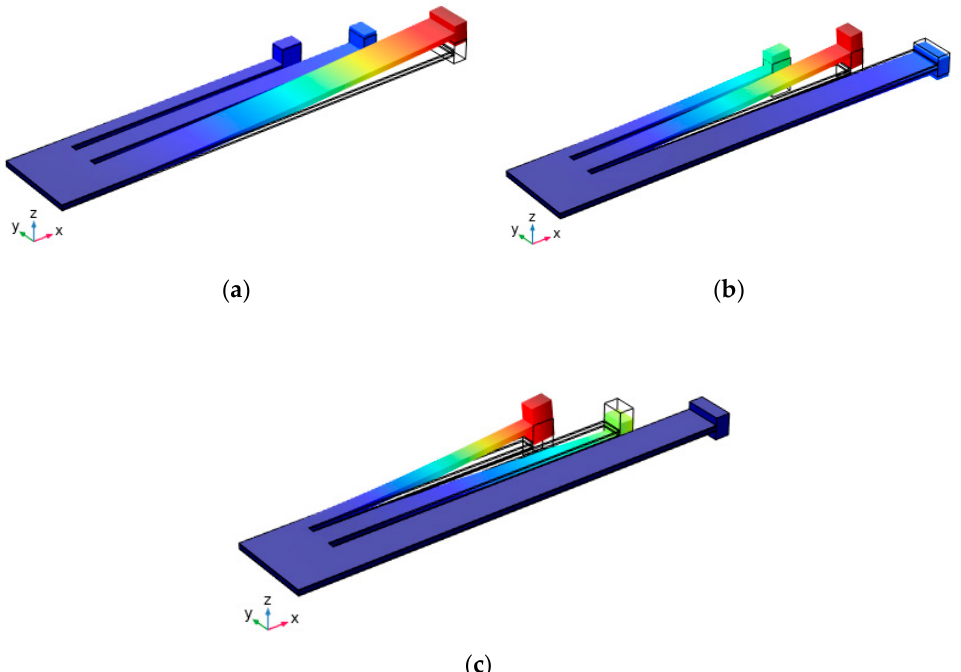
Figure 4. Mode shapes of the split cantilever multi-resonant energy harvester: ( a ) 1st mode shape (Eigenfrequency = 10.702 Hz); ( b ) 2nd mode shape (Eigen-frequency = 12.724 Hz) and ( c ) 3rd mode shape (Eigenfrequency = 14.007 Hz).